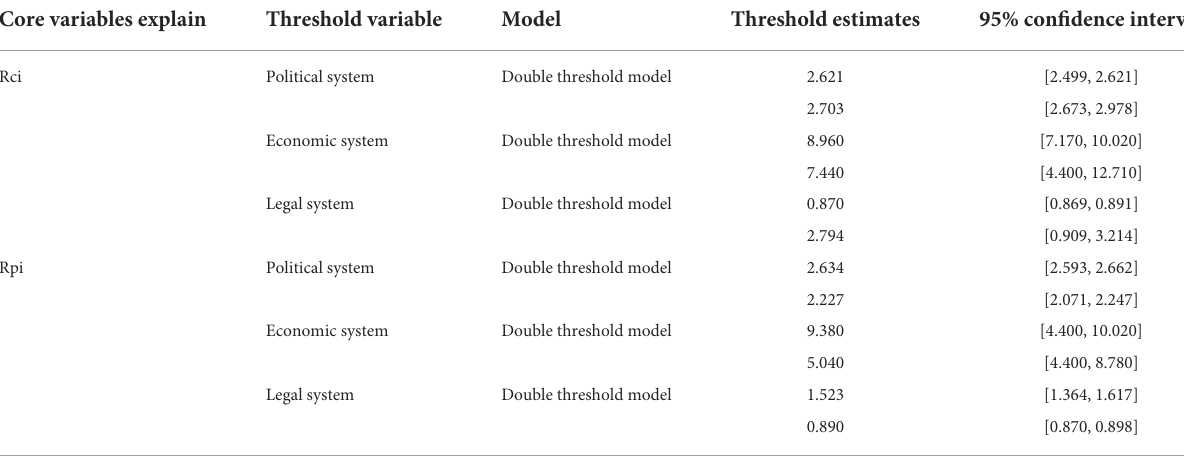
TABLE 4 Threshold estimates and their confidence